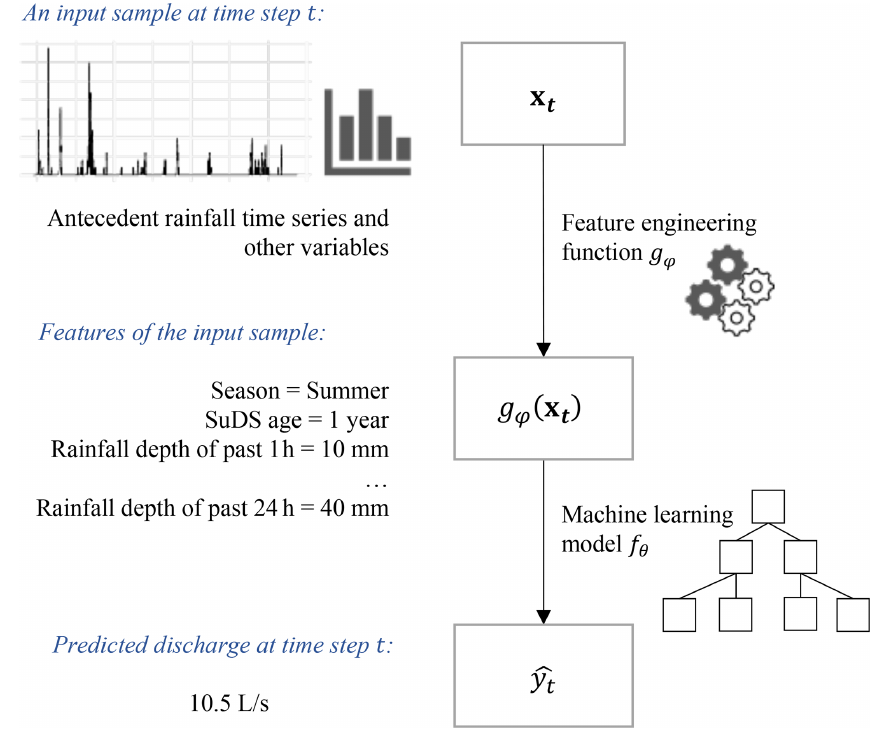
Figure 1. Illustration of the prediction generation process for an input sample x t .